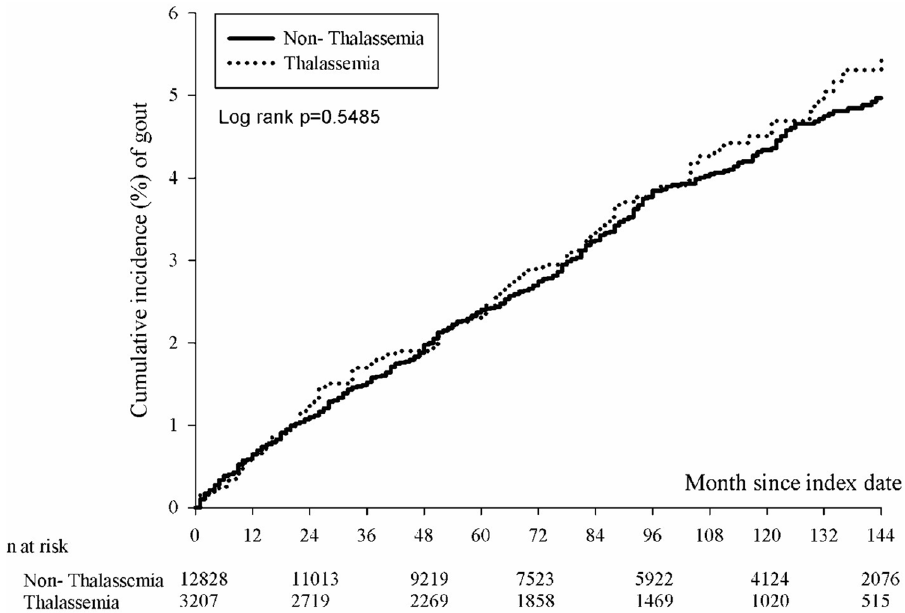
Figure 2. Cumulative Incidence of gout